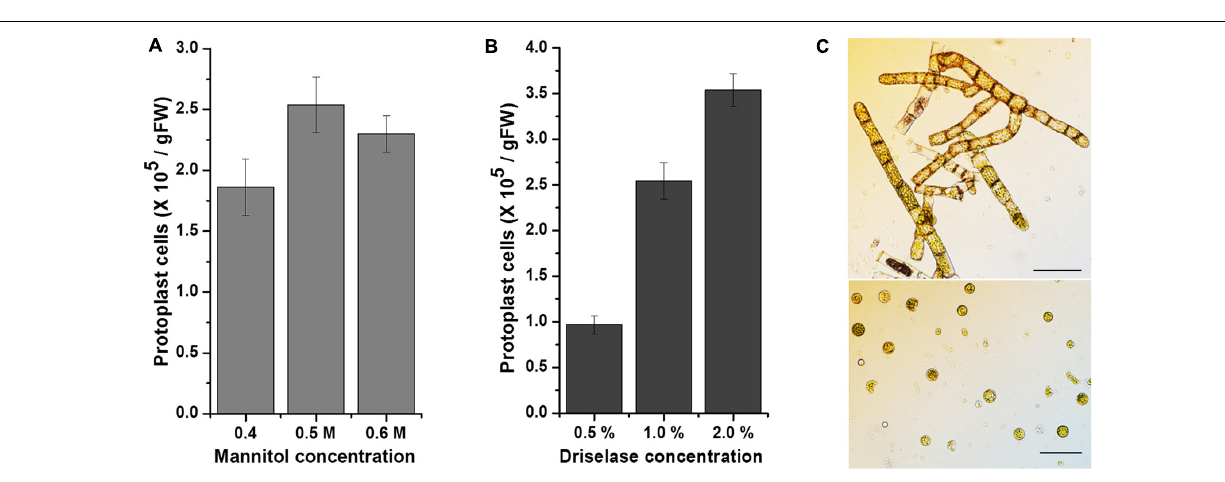
FIGURE 4 | Effects of mannitol and driselase concentrations on KMR5045 protoplast yield. Influence of (A) mannitol and (B) driselase concentrations on the isolation efficiency of KMR5045 protoplasts. (C) Seven-day-old protonema cells (upper panel) and isolated KMR5045 protoplast cells (lower panel). Scale bars (upper panel) 50 µ m; (lower panel) 20 µ